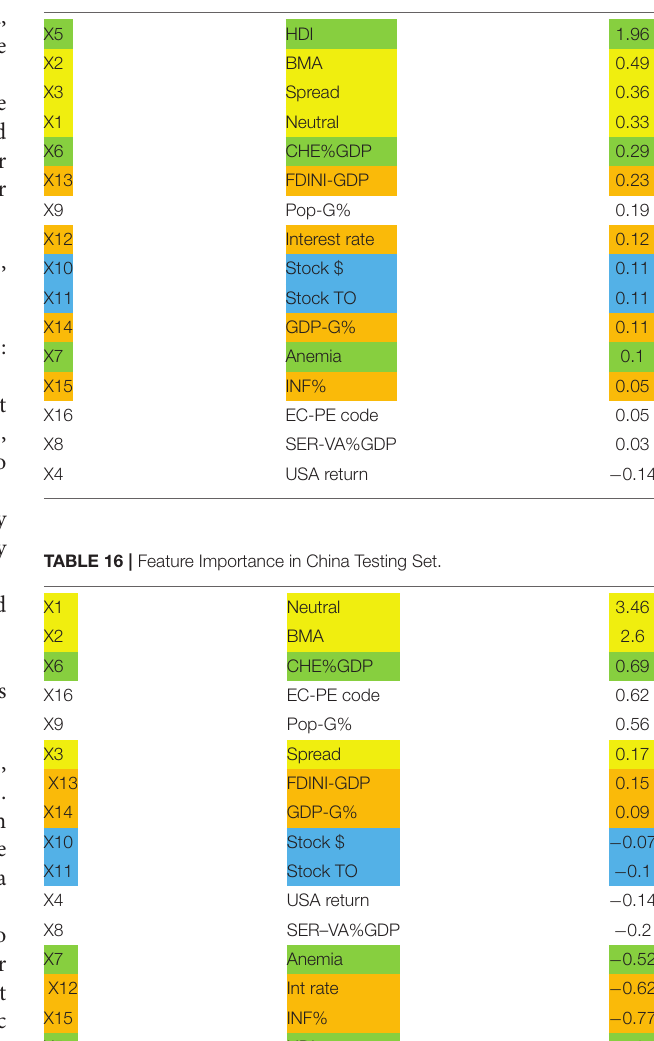
TABLE 15 | Feature Importance in Pooled Testing Set.